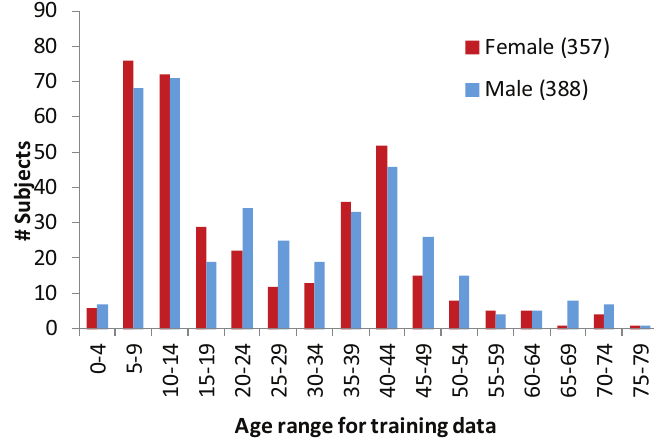
Figure 2. Distribution of subjects in training dataset—by age group and gender. The histogram demonstrates a non-uniform distribution of age groups though the distributions of both sexes are almost equally